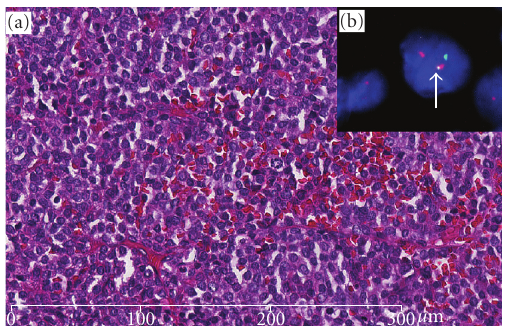
Figure 1: (a) The pictures show adipose and fibrous tissue with dense and di ff use infiltrate of monomorphic PML cells (H !E, 20 × ). (b) FISH revealed the presence of the reciprocal and balanced t(15;17) on PML cells